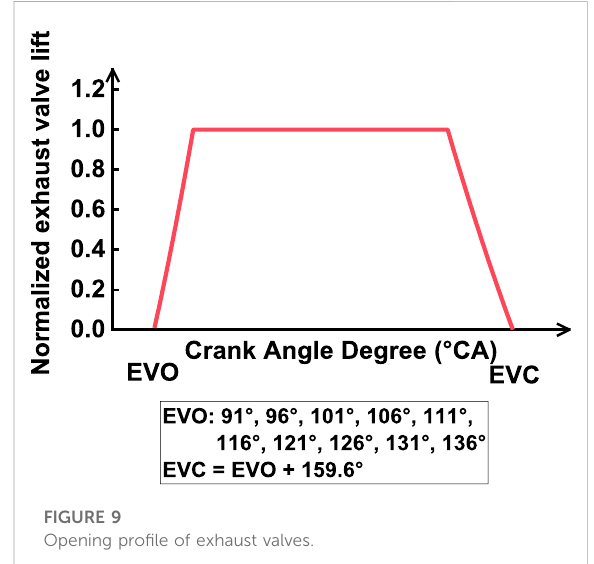
FIGURE 9 Opening pro fi le of exhaust